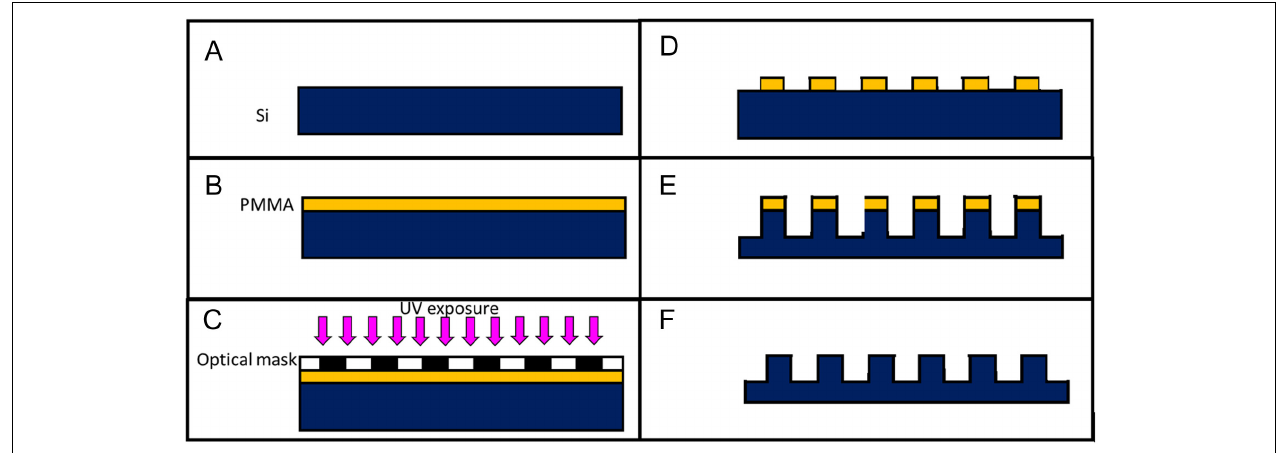
FIGURE 2 | Sketch of the mold fabrication process: a silicon substrate (Si) is cleaned in a ultrasonic bath (A) a photoresist (PMMA) is spun on top of the silicon substrate (B) the sample is exposed to UV after being masked (C) the exposed photoresist is dissolved in a solvent (D) the micropillars are dry-etched in the silicon sample (E) the remaining photoresist is removed with acetone (F)